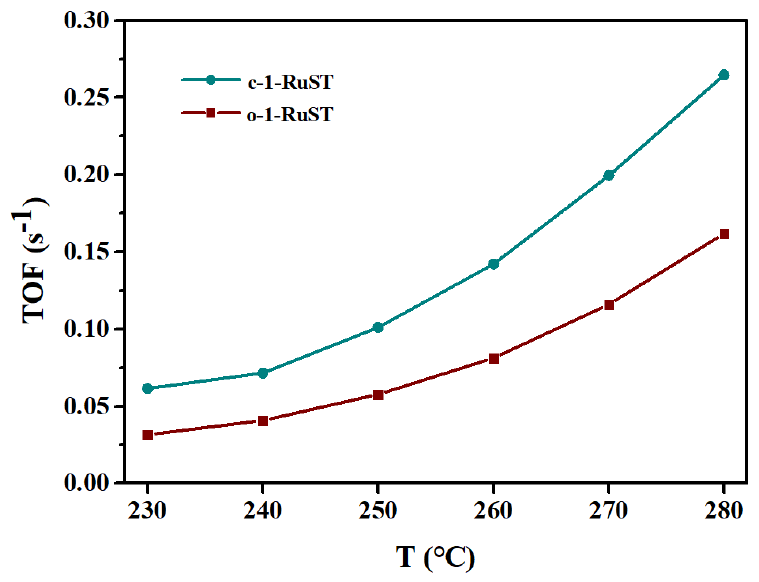
Figure 8. TOF for DCM oxidation on the c-1-RuST and the o-1-RuST sample. Test conditions: [DCM] = 1000 ppm, WHSV = 112,500 mL·g −1 ·h −1 .